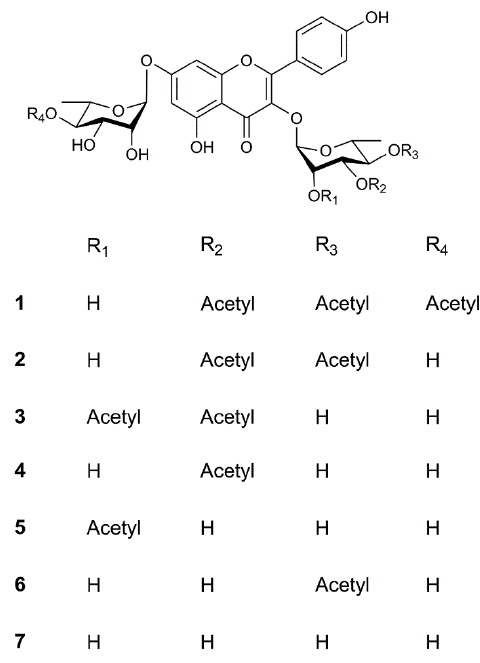
Figure 1. Structures of compounds 1 – 7 . Table 1. 1 H-NMR (600 MHz) and 13 C-NMR (150 MHz) data of compound 1 in CD 3 OD.